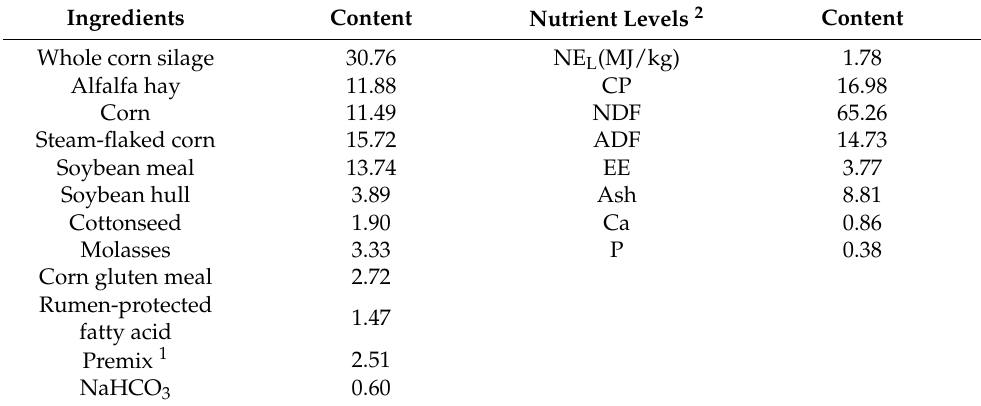
Table 1. Composition and nutrient value of basic diet (DM basis